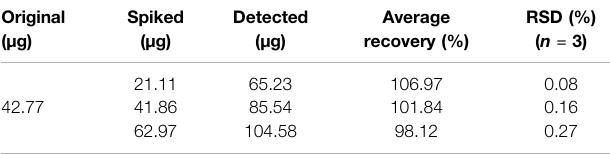
TABLE 4 | Recovery for the analysis of the asperulosidic acid.